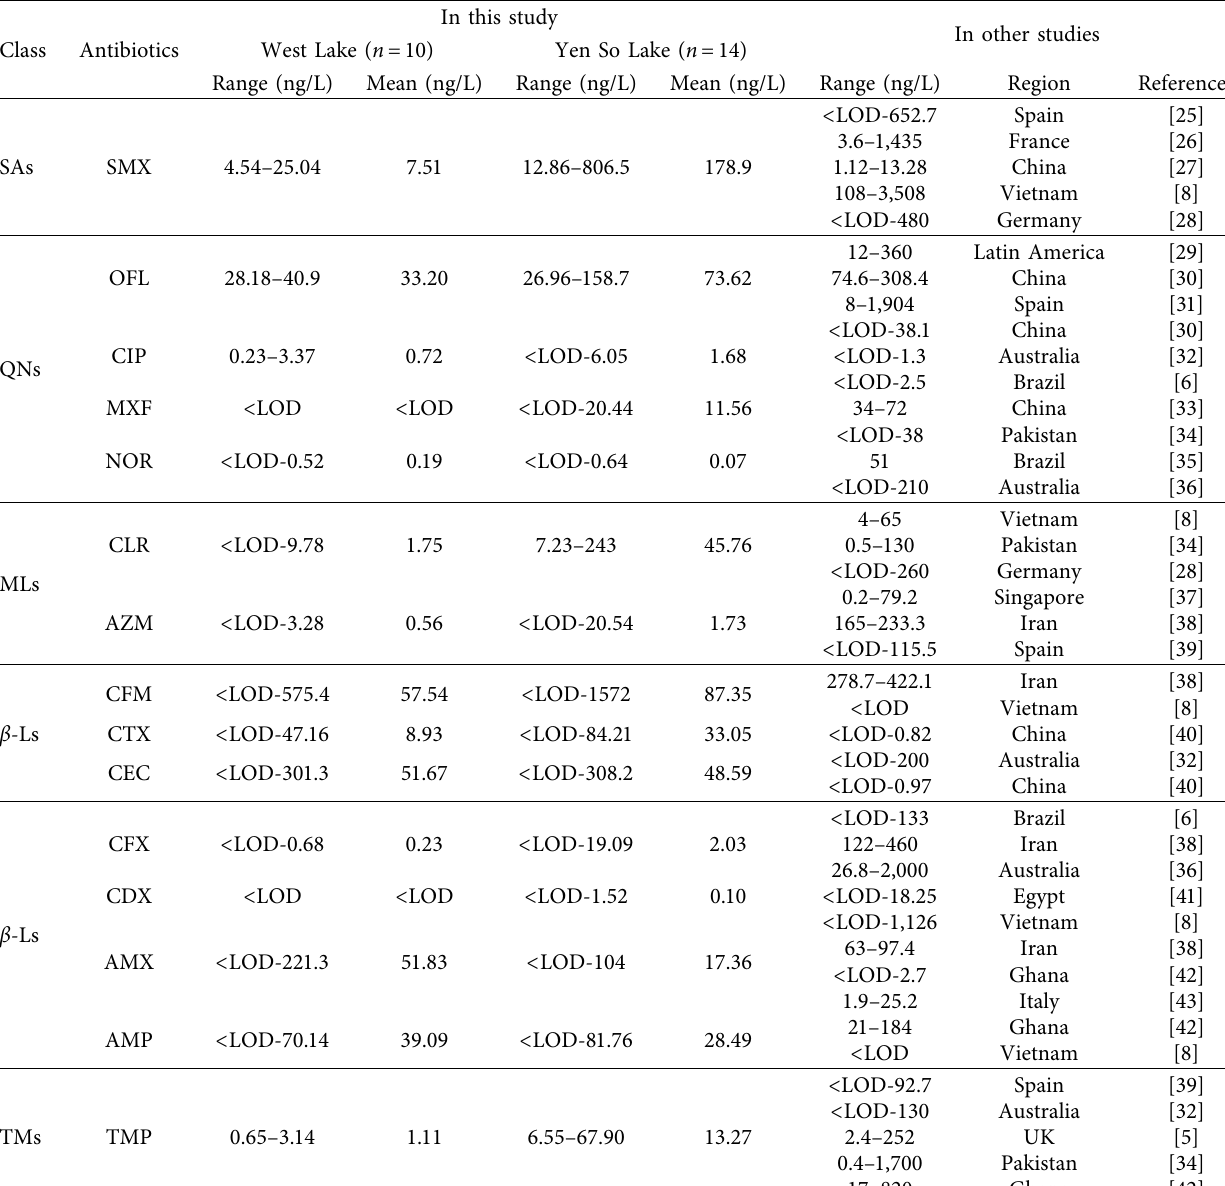
Table 3: Concentrations of antibiotics detected in surface water from two lakes in comparison with other rivers and lakes in other